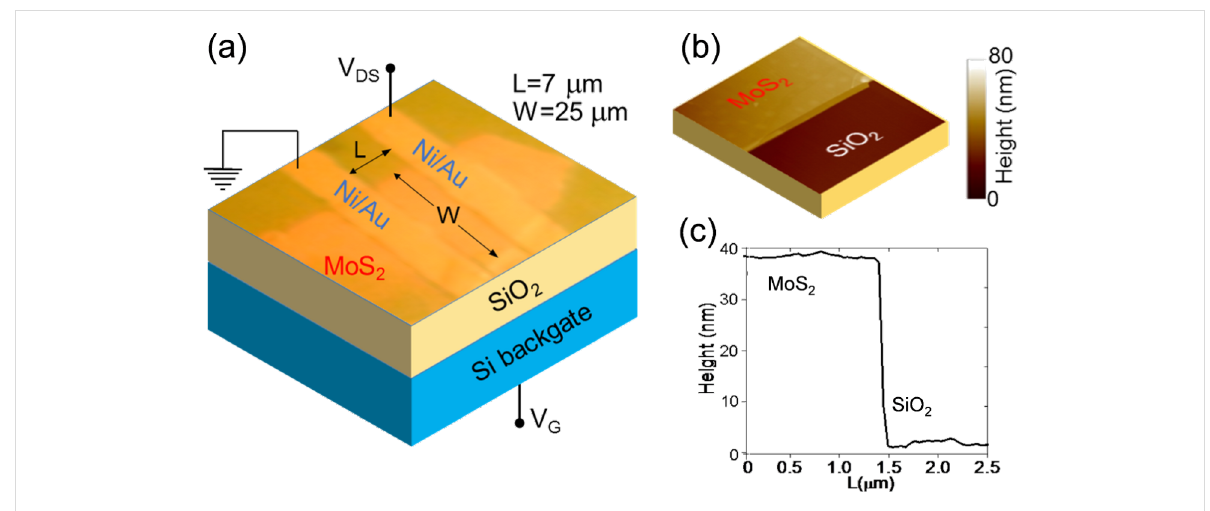
Figure 1: (a) Schematic including an optical image of a MoS 2 transistor with the SiO 2 /Si backgate and Ni/Au source and drain contacts. (b) Atomic force microscopy image and (c) the corresponding height linescan of the MoS 2 flake on the SiO 2 substrate.